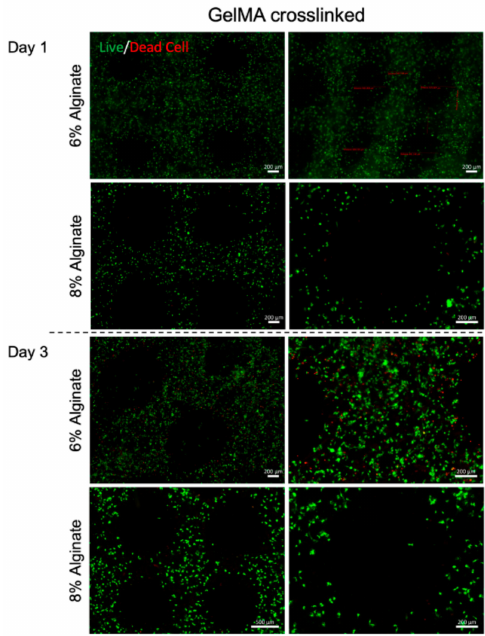
Figure 2. Live / Dead cell staining of C2C12 printed in GelMA hydrogel with alginate concentrations 6% and 8% (w / v) crosslinked with UV light. Images were taken on days 1 and 3 after bioprinting. Green color represents healthy cells and red color represents dead cells.